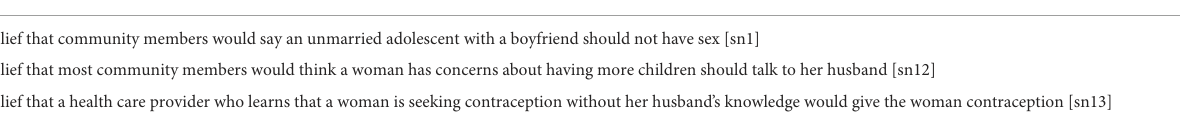
TABLE 3 FP social norm survey items discarded from the final three-factor